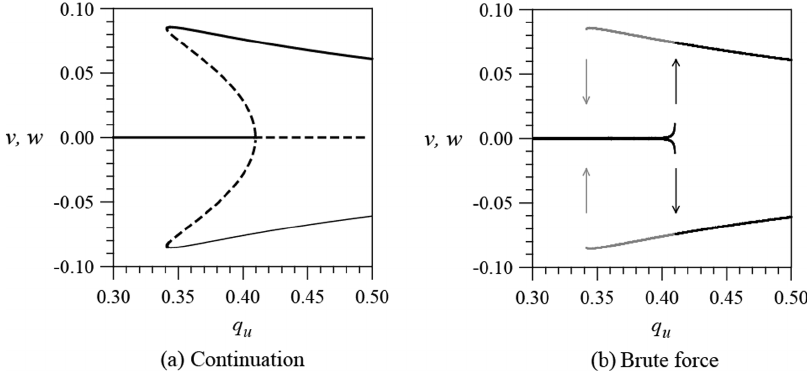
Fig. 5. Bifurcation diagram for Ω u = 2 ω 0 in the vicinity of the parametric instability bifurcation